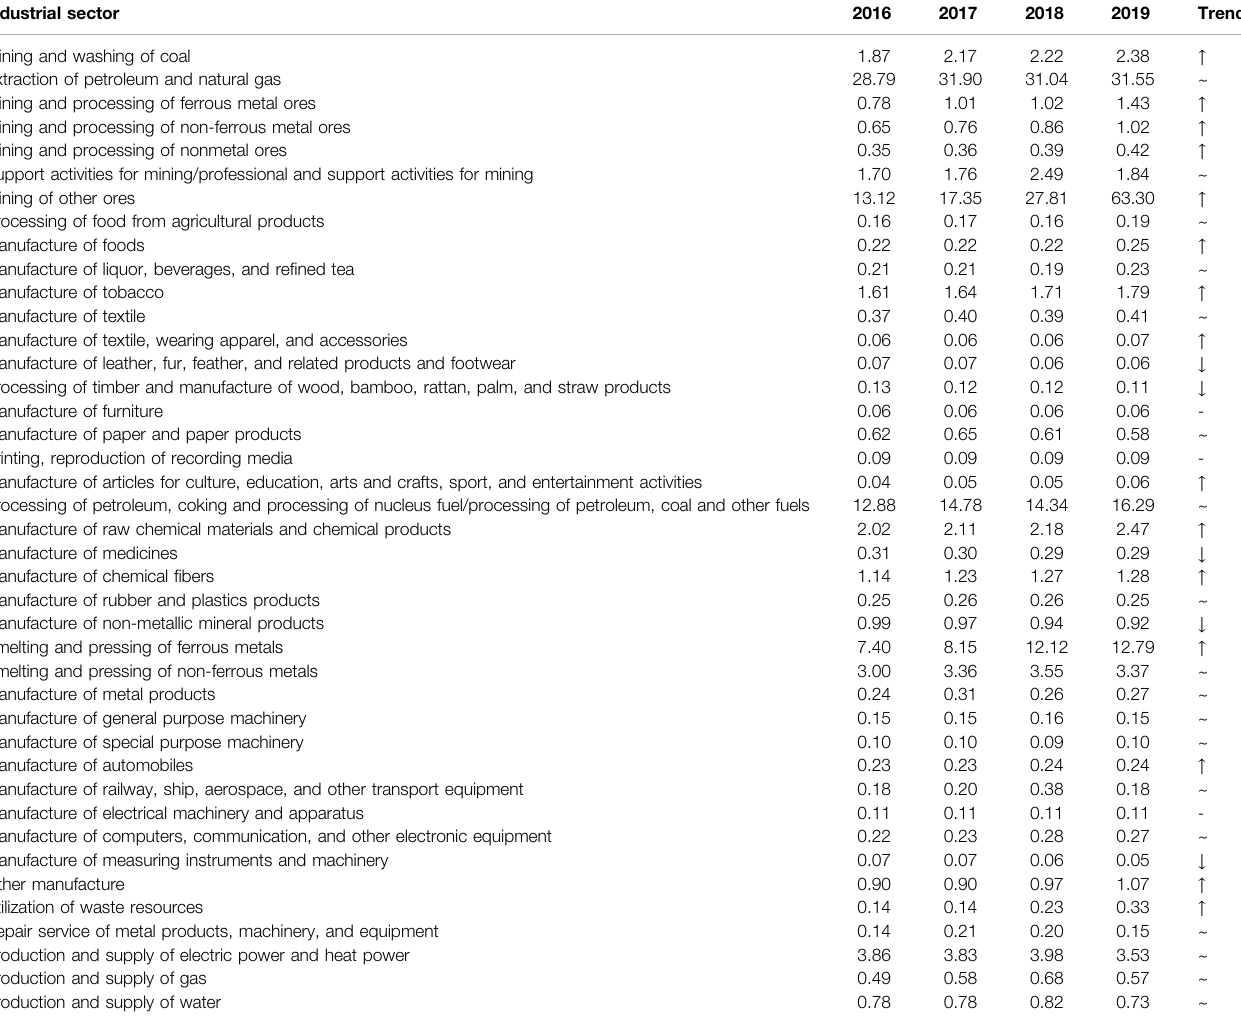
TABLE 1 | Enterprises ’ average energy consumption by industrial sector in China during 2016 – 2019 ( 10 4 tce/unit )